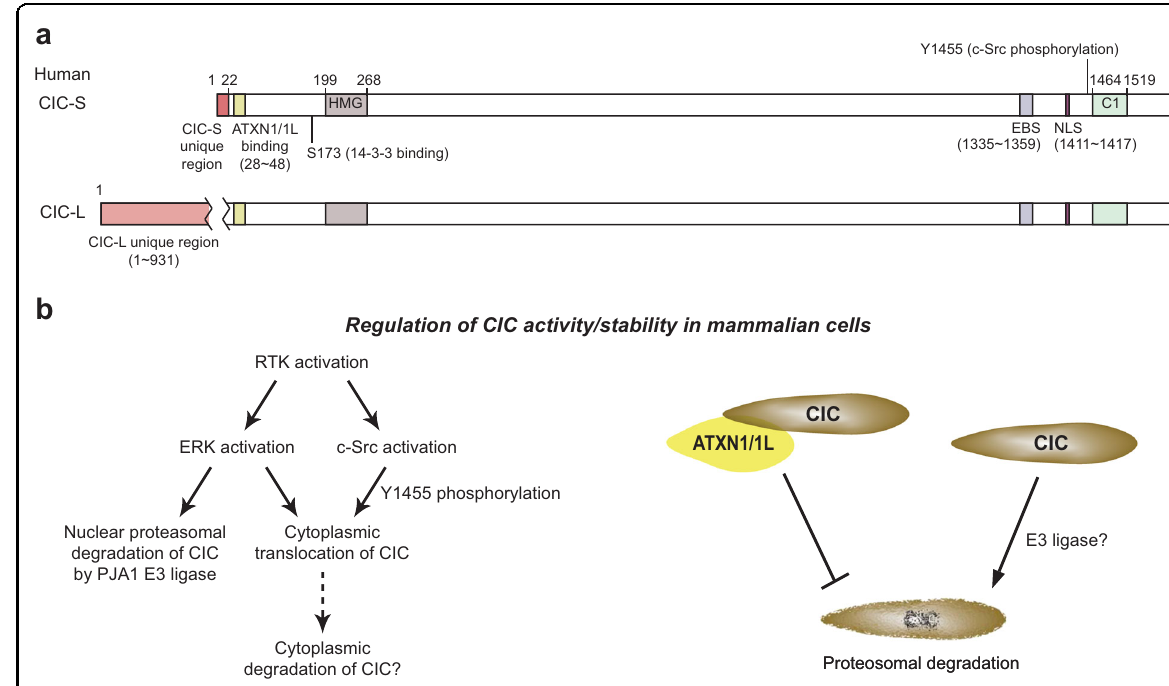
Fig. 1 Domain features and regulation of CIC. a Schematic illustration of human CIC-S and CIC-L. CIC-L has a unique long N-terminal region compared with CIC-S. The amino acid regions of CIC responsible for the interaction with ATXN1/ATXN1L, 14-3-3, and ERK, the HMG box, nuclear localization signal (NLS), c-Src-mediated phosphorylation site, and C1 domain, are depicted. Numbers indicate amino acid positions. EBS: ERK binding site. b Regulatory mechanisms for CIC activity and stability. The left panel shows the RTK-ERK activation-mediated degradation and/or cytoplasmic translocation of CIC in mammalian cells. It is unclear whether CIC is degraded in the cytoplasm of mammalian cells. The right panel depicts the ATXN1/ATXN1L-mediated protection of mammalian CIC from proteasomal degradation. The molecular machinery mediating the degradation of CIC in the absence of ATXN1 and ATXN1L is